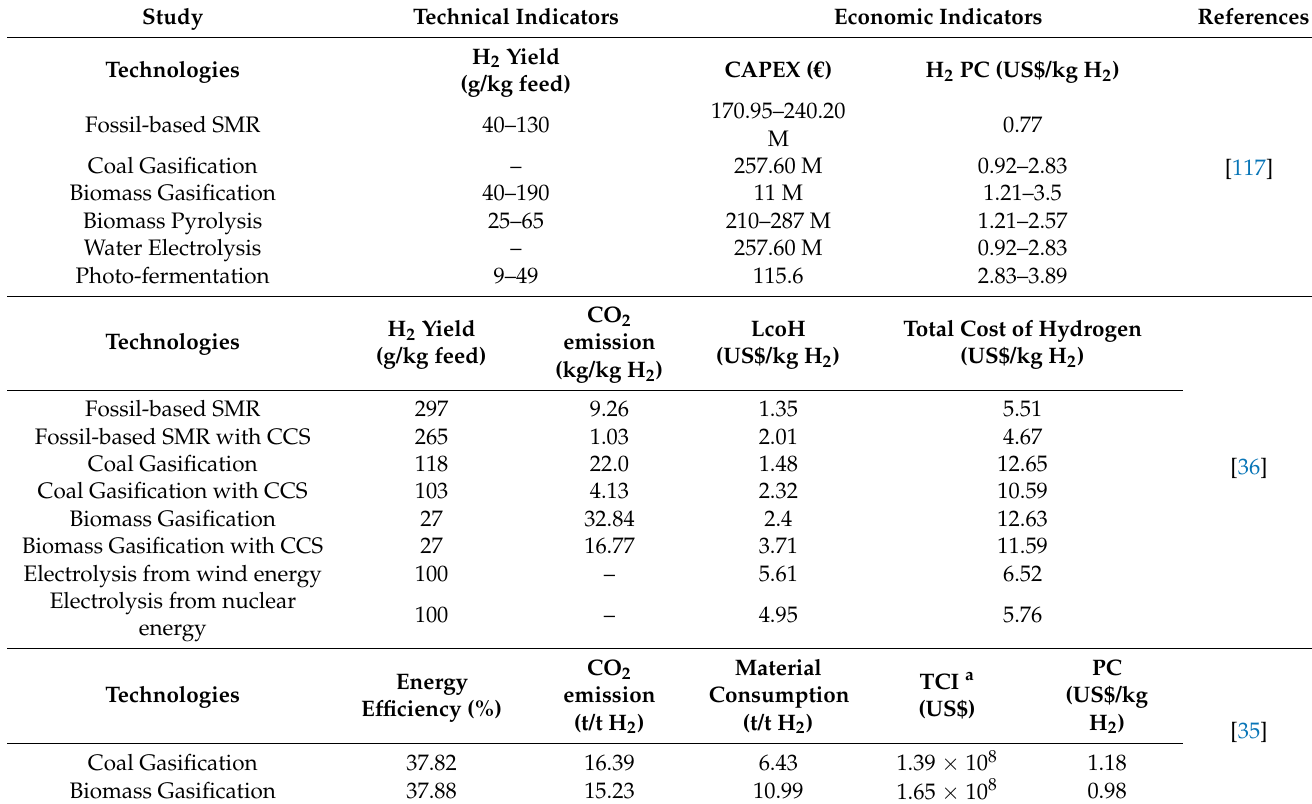
Table 9. Overview of techno-economics studies on biomass